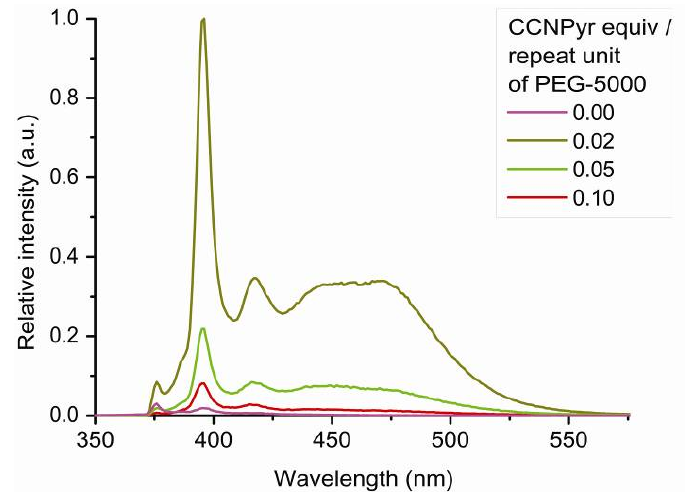
Figure 8. Photoluminescence spectra (emission mode, excitation at 317 nm) of “host-guest” materials PEG-5000/CCNPyr in the solid state.